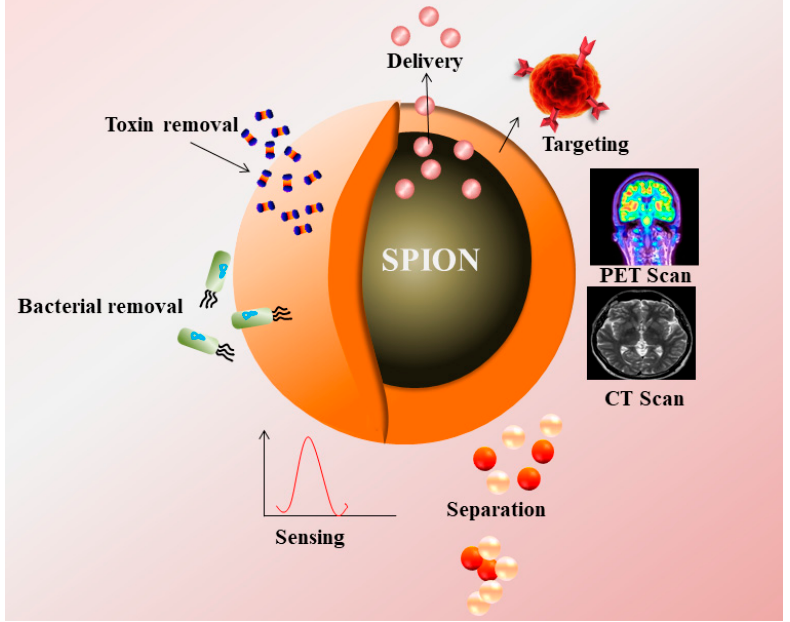
Figure 1. Superparamagnetic nanoparticles (SPIONs) as a contrast agent in PET, CT Scan, and their applications in targeting, drug delivery, removal of toxin, bacteria, and sensing.